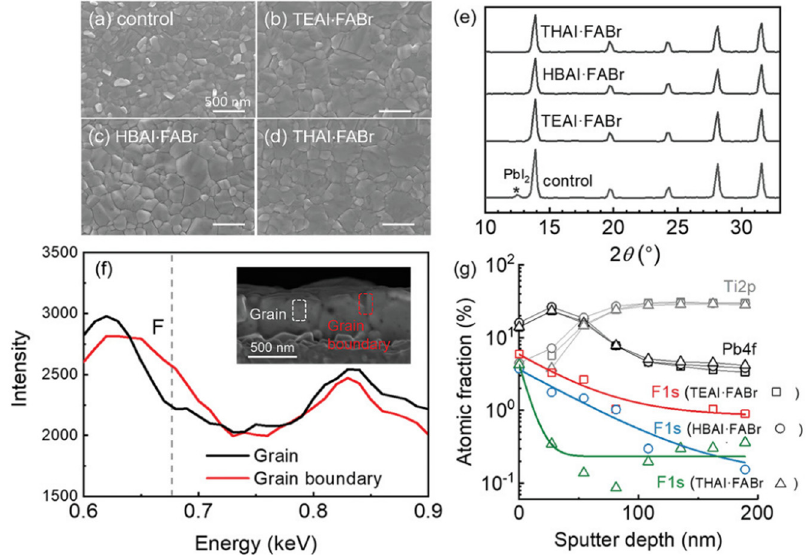
Figure 4. Top-view HR-SEM images of perovskite. ( a ) Control films and perovskite film with treatment of ( b ) TEAI ∙ FABr, ( c ) HBAI ∙ FABr and ( d ) THAI ∙ FABr. ( e ) GIXRD patterns of pristine film and passivated perovskite film with TEAI ∙ FABr, HBAI ∙ FABr and THAI ∙ FABr. ( f ) EDS spectra of the grain boundary and grain of the TEAI·FABr treated perovskite film. ( g ) XPS depth profiling spectra of the post-treated films with TEAI ∙ FABr, HBAI ∙ FABr and THAI ∙ FABr. Copyright from reference [29].